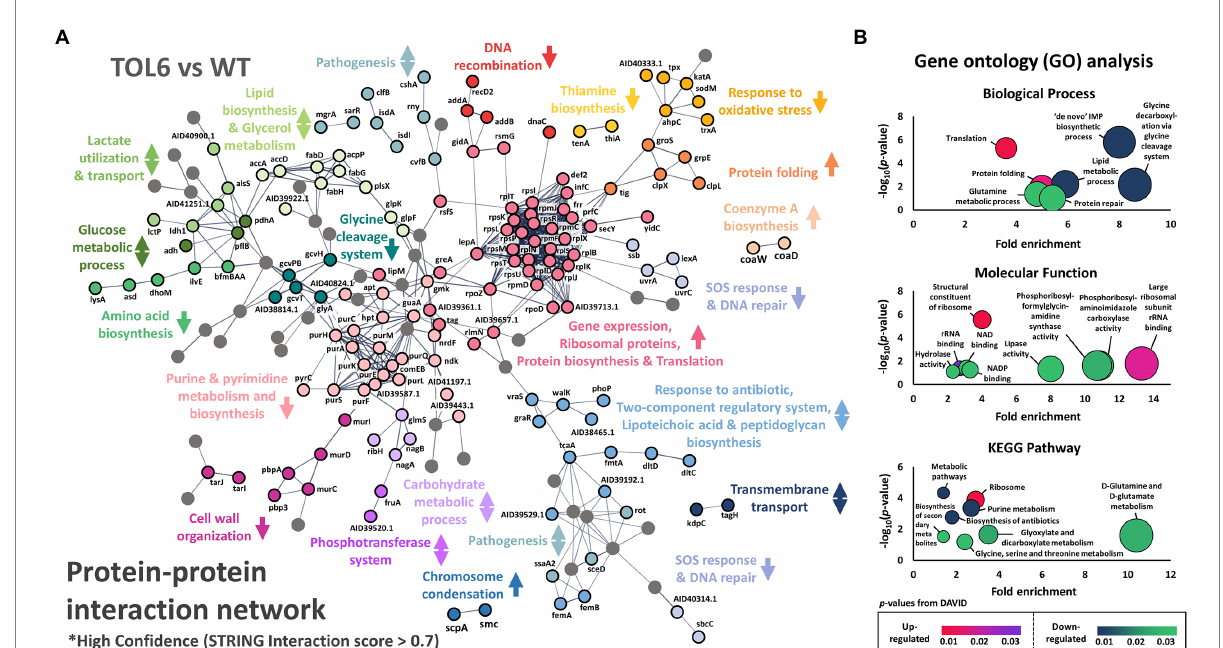
FIGURE 2 Differentially expressed proteins in the TOL6 strain compared to the ancestral strain. (A) Protein–protein interaction network of the DEPs of TOL6 strain compared to the ancestral strain, as predicted by STRING v11.0. The lines represent protein interaction (thicker lines mean higher confidence), and the dots in different colors represent different protein functions. Only high confidence protein–protein interactions are shown (STRING interaction score above 0.7). The arrows beside the protein function indicate the direction of expression of the process (the arrows pointing upwards mean that the process is expressed higher in TOL6, the arrows pointing downwards mean the process is expressed higher in ancestral strain, while arrows pointing both upwards and downwards mean that in a specific process, some proteins are expressed higher in TOL6 and some that are expressed higher in the ancestral strain). Nodes without function enrichment are colored gray. (B) Gene Ontology (GO) analysis, classified by the biological process (top) and molecular function (middle), and pathway enrichment study (KEGG; bottom) by DAVID of the DEPs of TOL6 compared to the ancestral strain. Fold enrichment is defined as the ratio of the proportion of the input information to the background